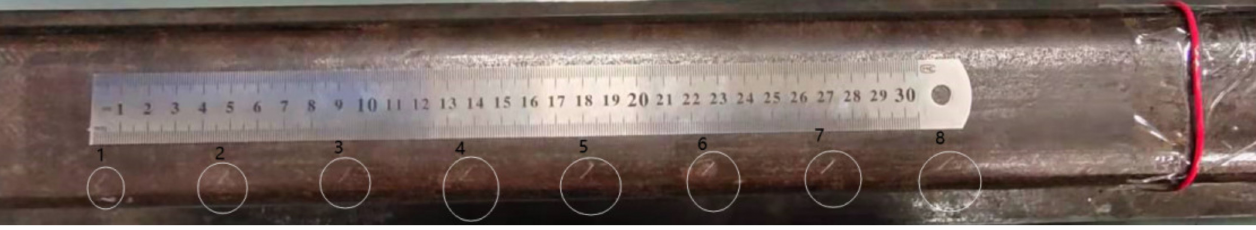
Figure 12. A rail with multiple artificial